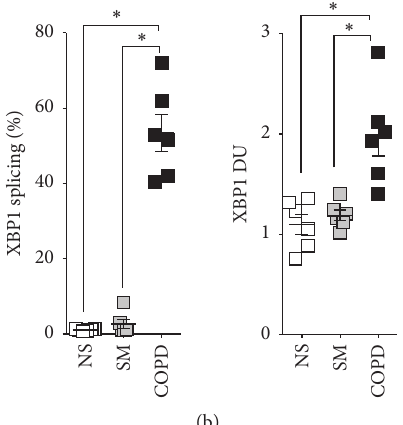
Figure 2: NHBE cells isolated from COPD donors have enhanced ER stress protein responses compared to nonsmokers and smokers. Protein was collected from fully differentiated NHBE cells from nonsmokers (NS), smokers (SM), and COPD (COPD) individuals ( 𝑛 = 6 donors per group). (a) Protein expression of ATF6, ATF4, GRP94, GRP78, EDEM, CHOP, and 𝛽 -actin was examined by immunoblots. Phosphorylation of elF2 and PERK was also determined. (b) XBP1 splicing was examined on XBP1 amplified cDNA from NHBE cells from nonsmoker (NS), smokers (S), and COPD (COPD) individuals. Protein expression of XBP1 and 𝛽 -actin was examined by immunoblots. (a)-(b) For each blot or gel, every lane represents an individual cell donor. Densitometry analysis was performed of XBP1s from DNA gels and other targets by analyzing immunoblots. XBP1 slicing was scored as percent of XBP1s of total XBP1. Dot plots are represented as densitometry units (DU) of pixel intensityexpressed asaratioto 𝛽 -actinortotal elF2and PERK.Data areshown asmean ± SEM,whereeach measurementwas performed on 3 independent days on 6 donors/group. ∗ denotes 𝑝 value < 0.05, when comparing both treatments connected by a line, determined by 2-way ANOVA with Tukey’s post hoc test ( > 2